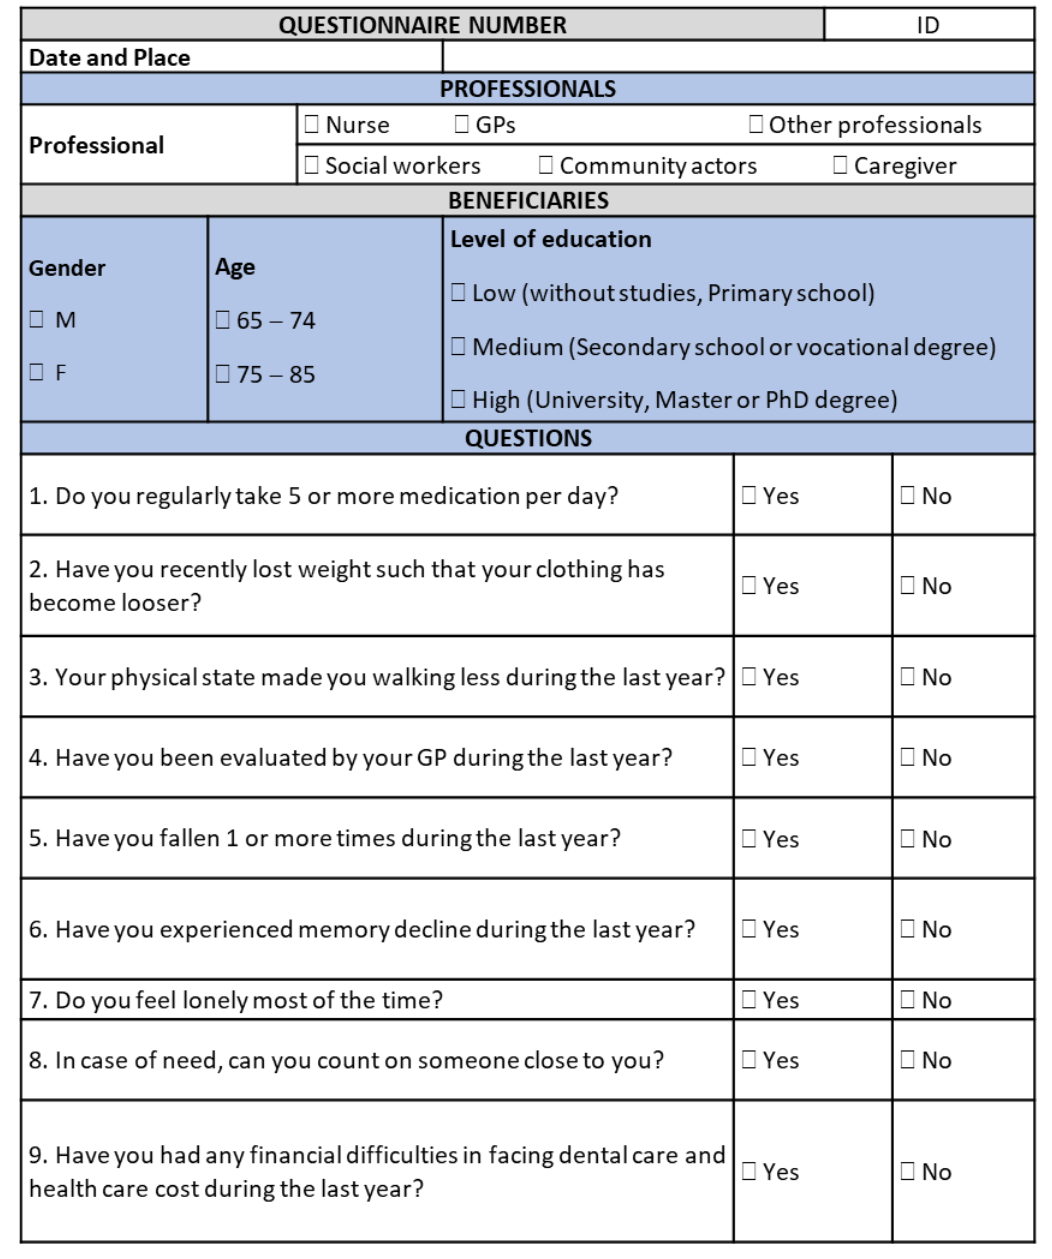
Figure 1. The SUNFRAIL assessment